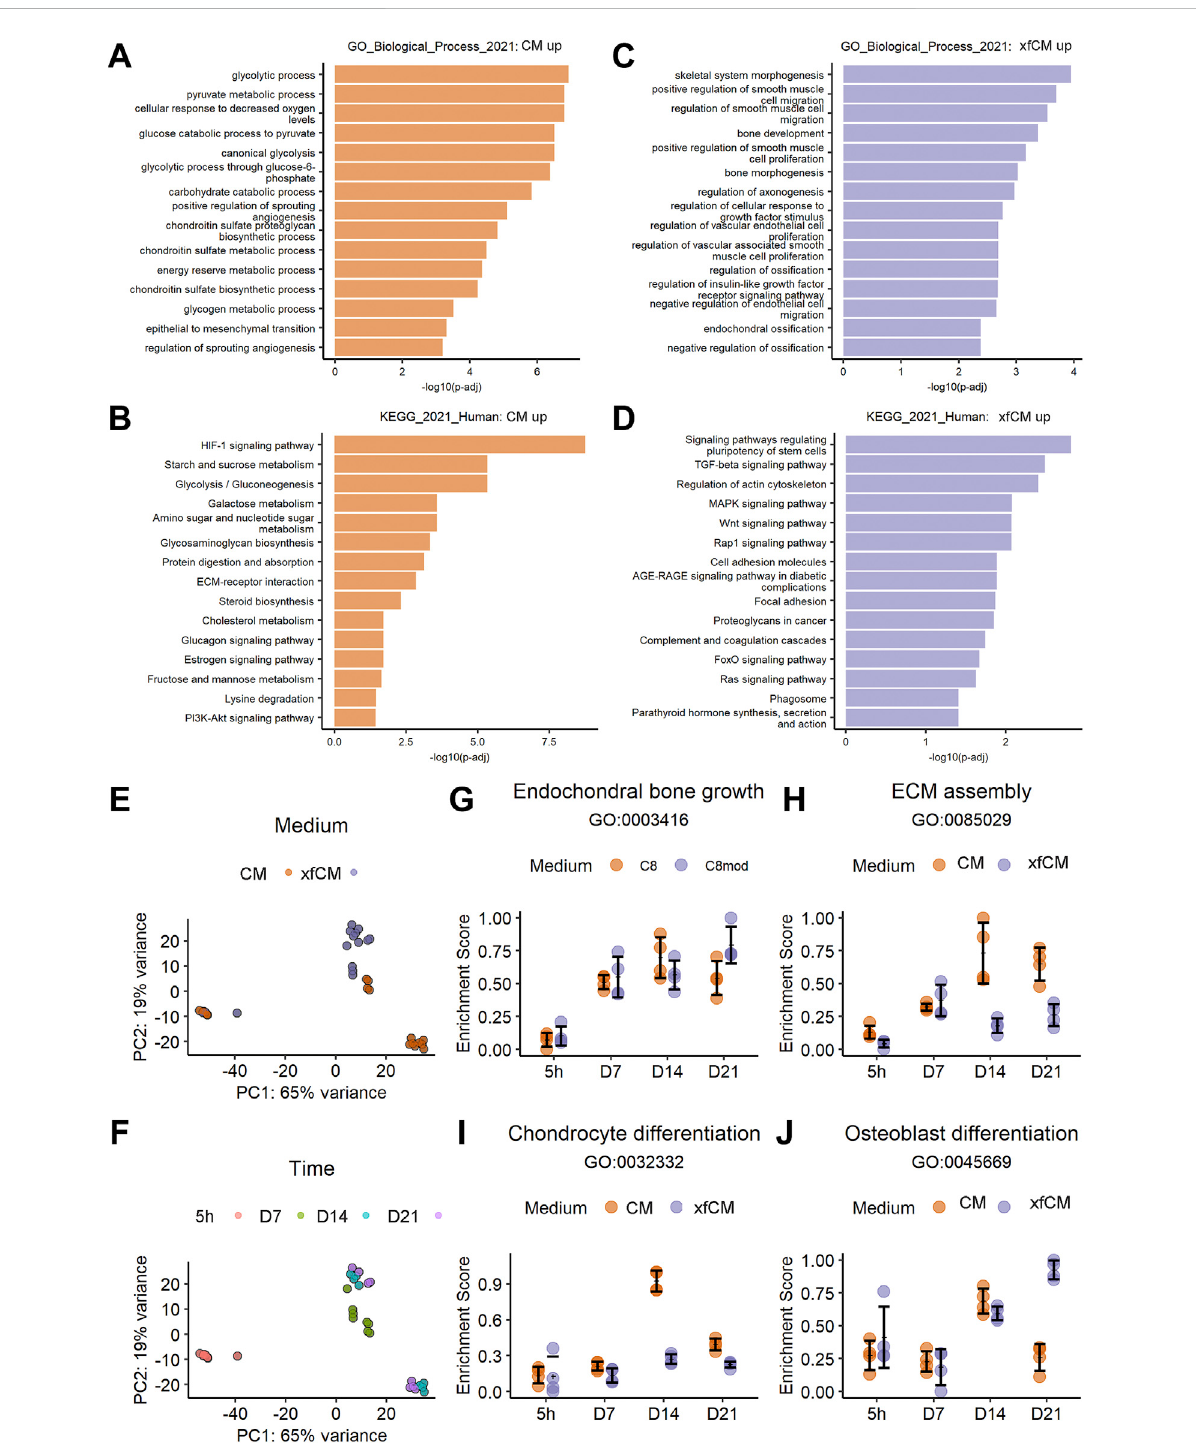
FIGURE 3 RNA sequencing of bone-forming microtissues during differentiation. (A,B) Gene ontology, biological process, and KEGG pathway terms upregulated in CM in the 500 most variable genes. (C,D) Gene ontology, biological process, and KEGG pathway terms upregulated in xfCM in the 500 most variable genes. (E,F) Principle component analysis performed on the full transcriptome of microtissues in CM and xfCM at 5 h, 7, 14, and 21 days. (G – J) Temporal gene set scoring on the full transcriptome over time for genes grouped in a given GO term. Data are presented as mean ± standard